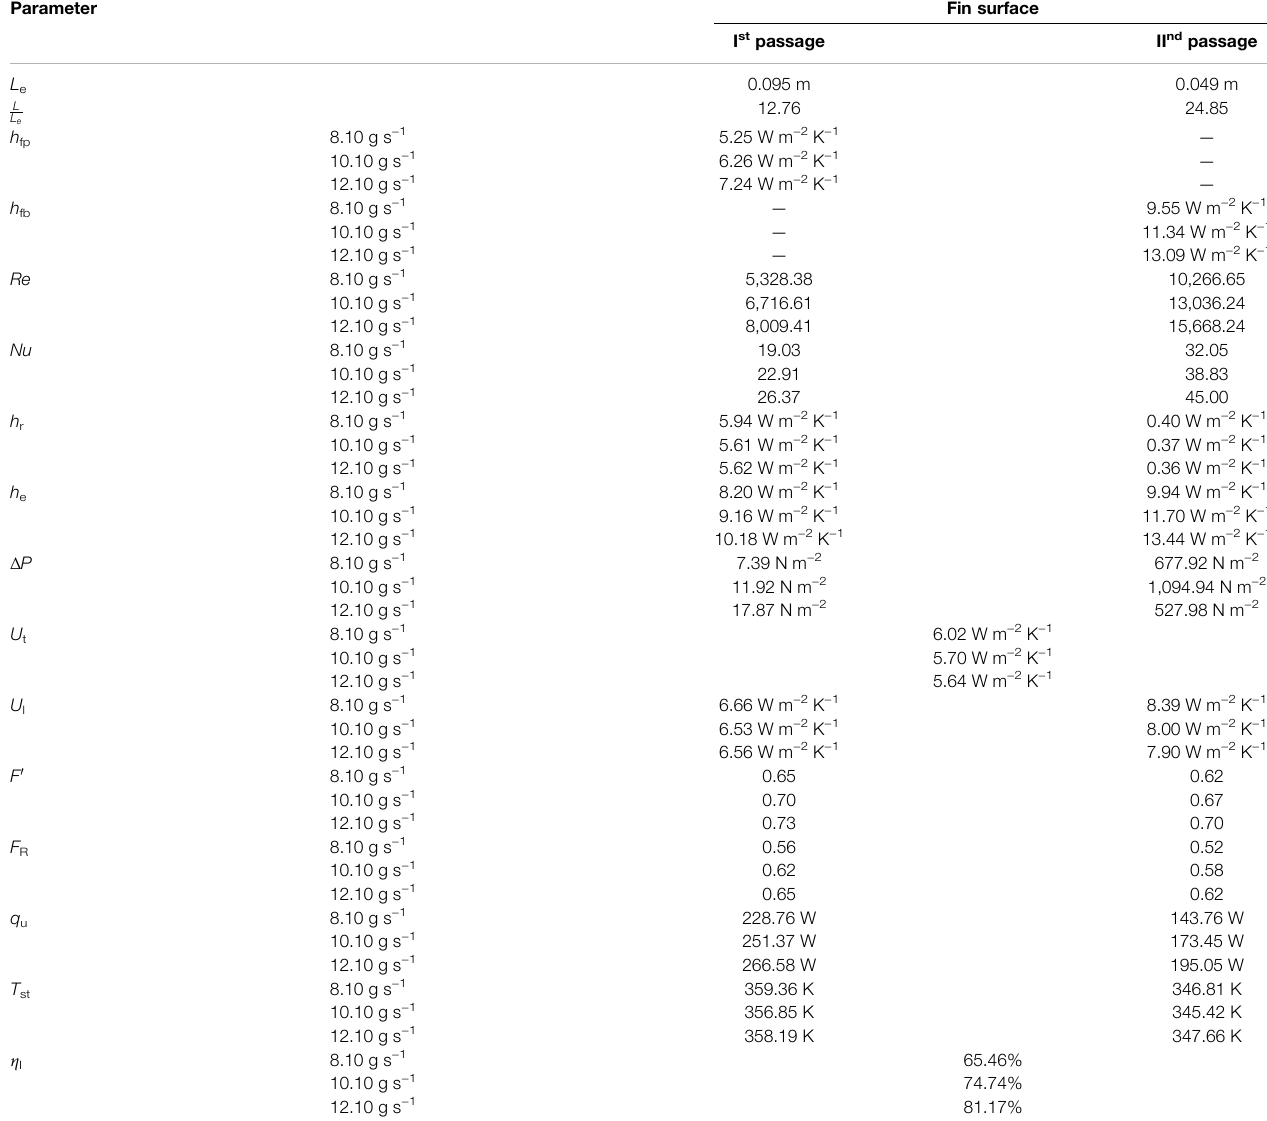
TABLE 6 | Parametric information of solar air collectors ( fi nned plate collector with two-pass).